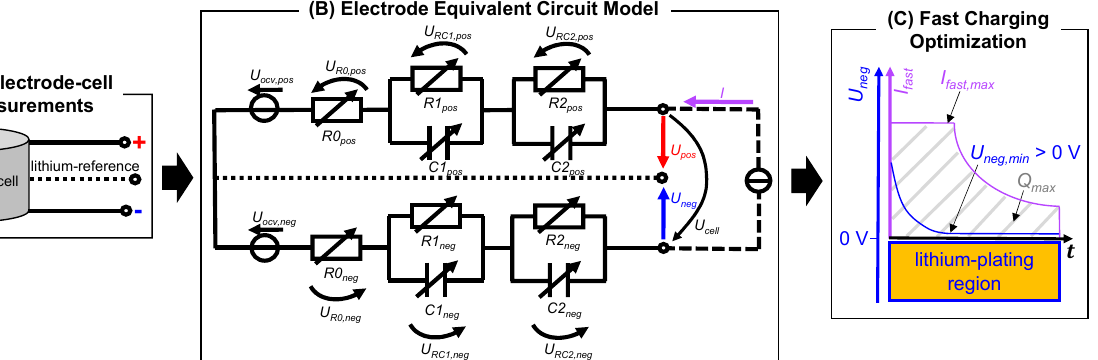
Figure 1. Fast-charging optimization approach based on an Electrode Equivalent Circuit Model (EECM) which is parameterized by 3-electrode cell measurements. ( A ) Measurements with 3-electrode cells are the input for the EECM parameterization (details in Section 2.2). ( B ) EECM with an open circuit voltage source ( U ocv ), ohmic resistance ( R0 ) and two RC branches ( R1 , C1 and R2 , C2 ) per electrode. ( C ) The control of the voltage of the negative electrode ( U neg ) to non-negative values allows the optimization of fast-charging current profiles ( I fast ) without lithium-plating. The model approach is based on Drees et al. [52] and is further advanced to two RC branches, in order to increase the simulation fidelity.